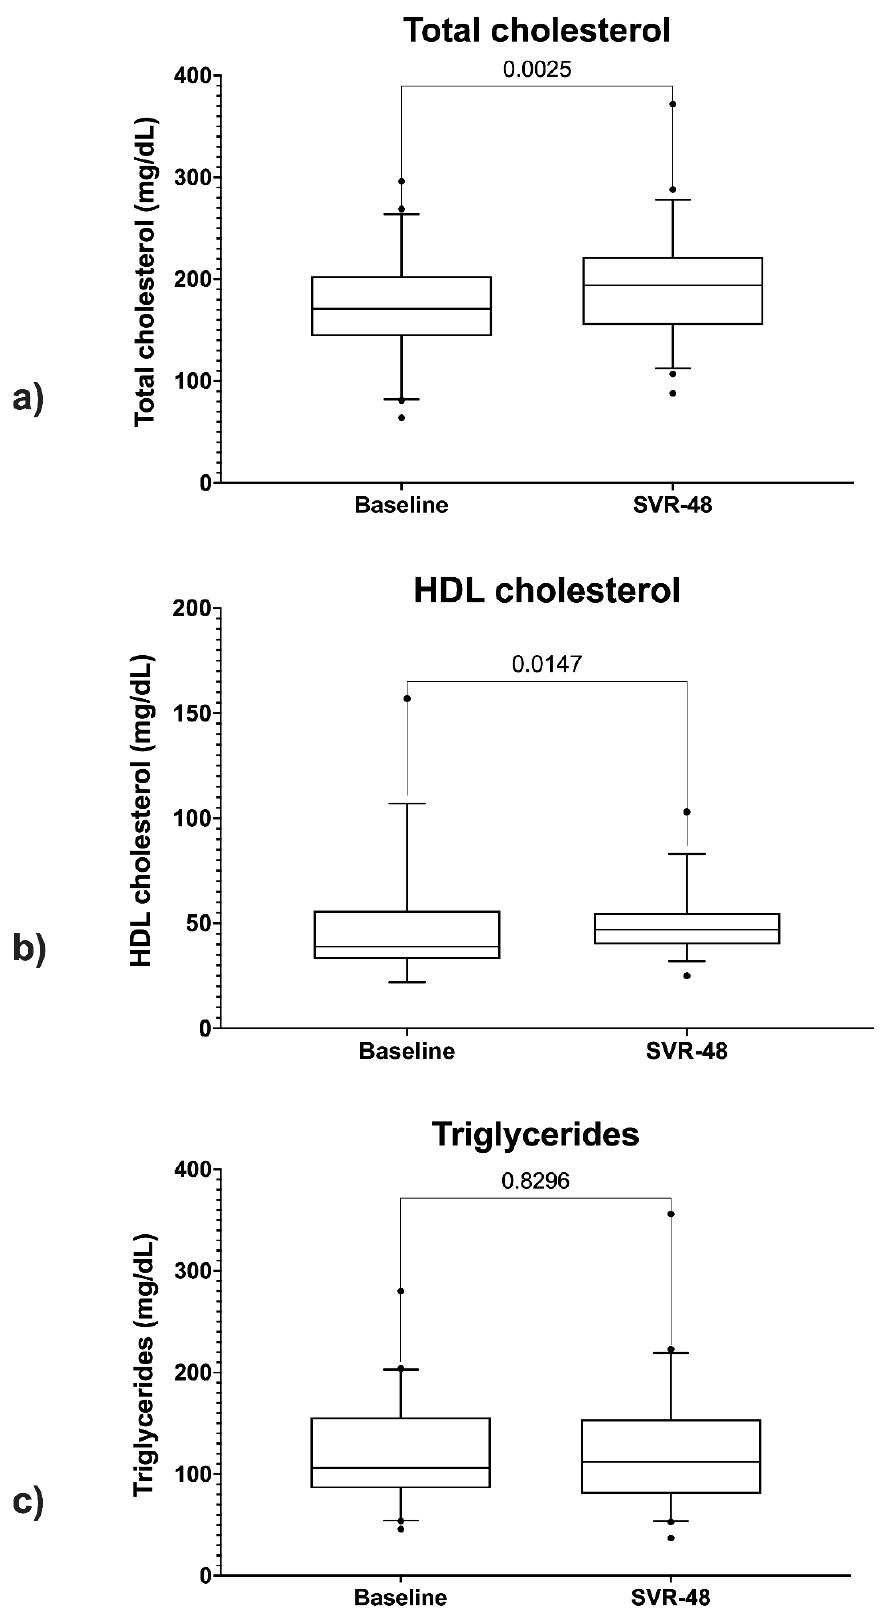
Figure 6. Comparison between total cholesterol levels ( a ), HDL levels ( b ), and triglycerides ( c ) at baseline and SVR48.